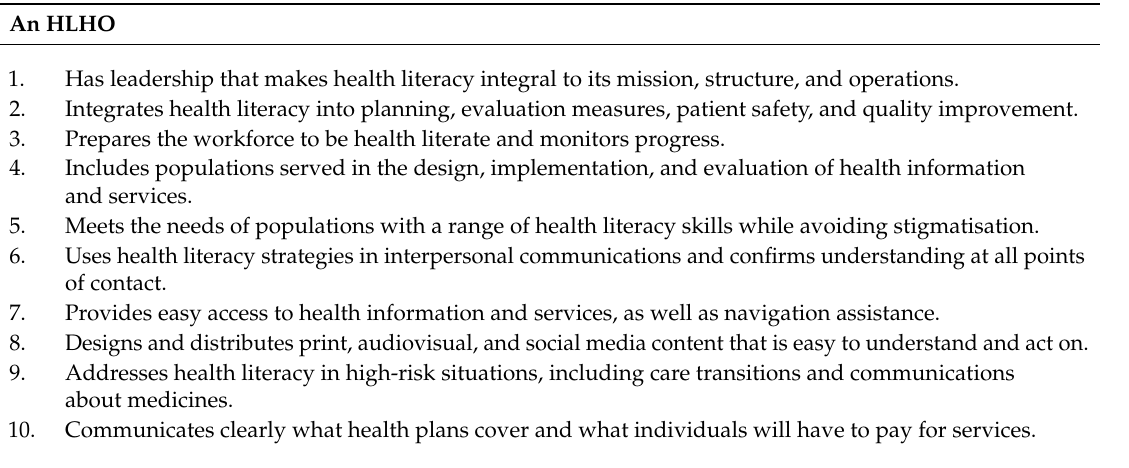
Table 1. Ten attributes to the health literate health care organizations (HLHOs), according to the Institute of Medicine (IOM)